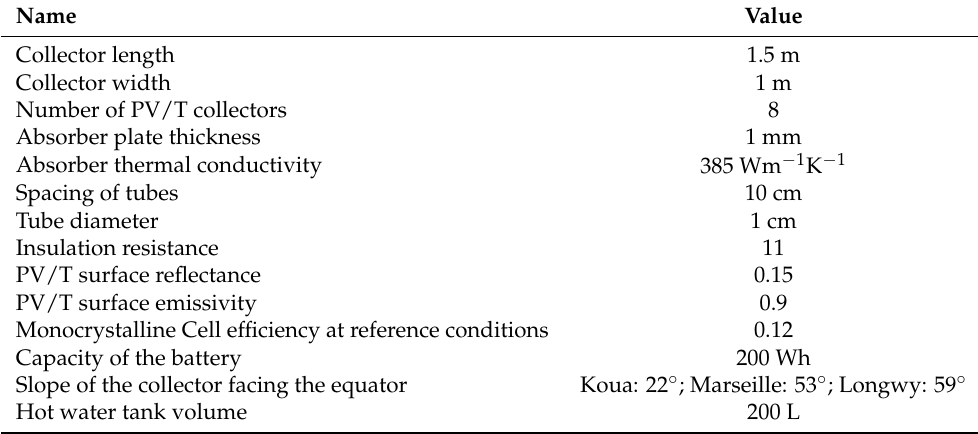
Table 1. summary of the main features of the PV/T